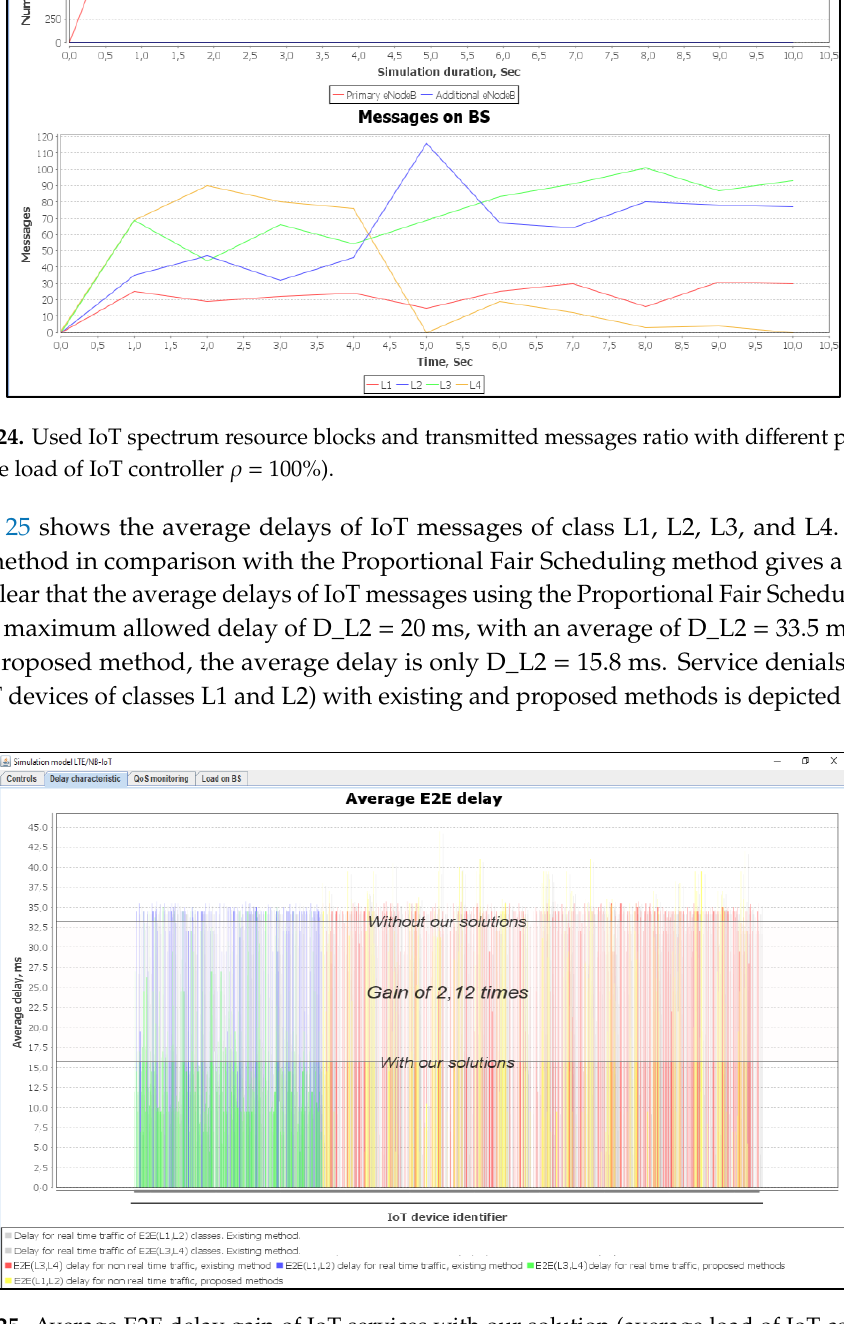
Figure 25. Average E2E delay gain of IoT services with our solution (average load of IoT controller ρ = 100%).